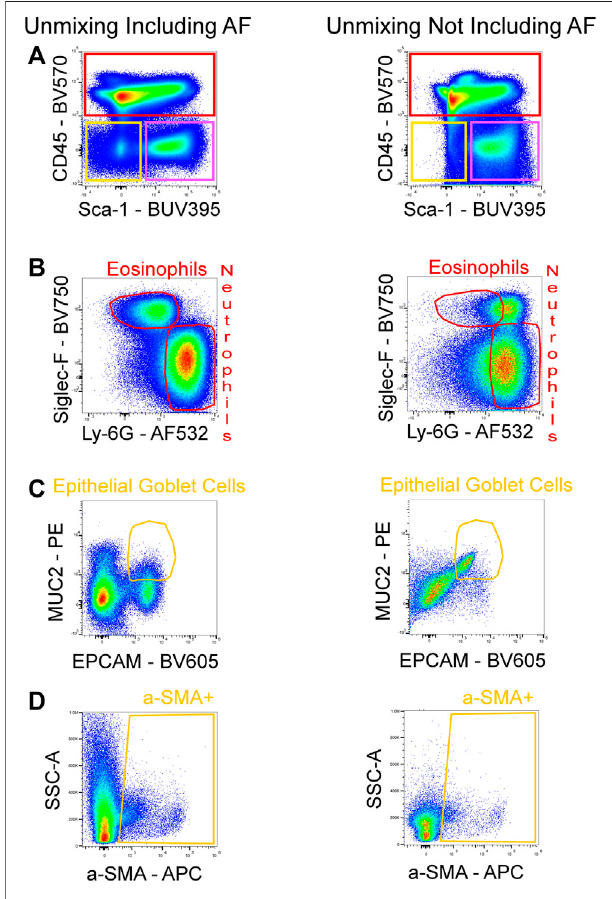
FIGURE 7 | Improved resolution of fully stained sample with AF included in unmixing. AF was either included or not included in the unmixing of the fully stainedsample.ByincludingtheAFintheunmixing,theresolutionforBUV395 was enhanced, enabling for better detection of the non-hematopoietic/ non-EC fraction (CD45-/Sca-1-; yellow gate) (A) . Increased resolution for AF532 was also seen, allowing for the detection of eosinophils (B) . The absence of AF in the unmixing masked the signals of PE and BV605 which reduced the resolution between these fl uorophores and lead to false positives of epithelial goblet cells (C) . The poor identi fi cation of the non-hematopoietic/ non-EC subset in (A) resulted in the loss of events downstream in the gating strategy as seen by a reduced α -SMA + population (D)